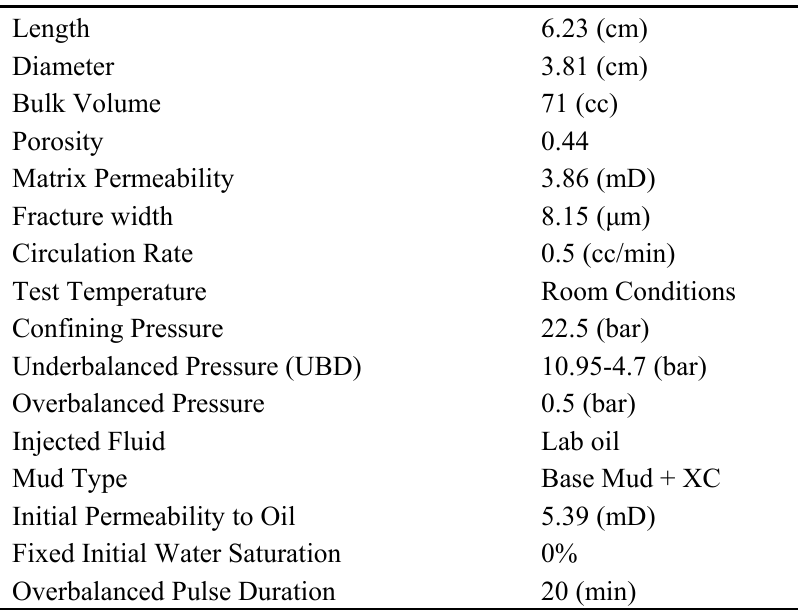
Table 6. UBD leak-off test with water-based mud; Sample